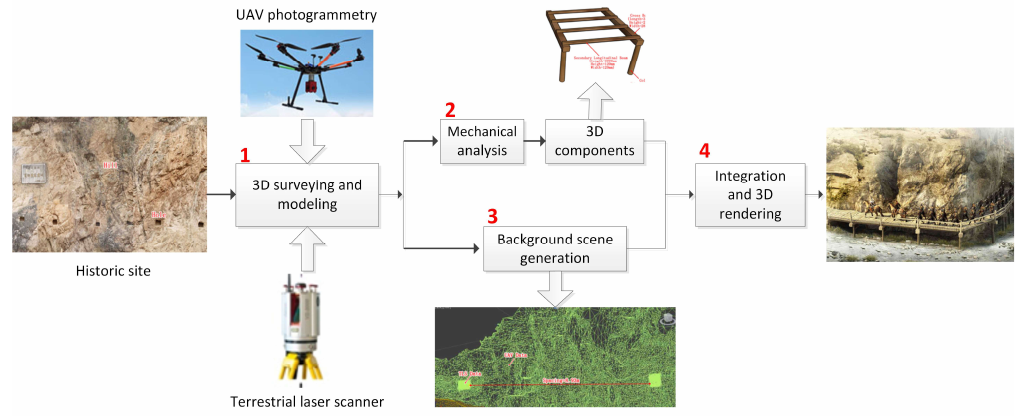
Figure 3. Proposed idea for the 3D restoration of Chiya Plank Road